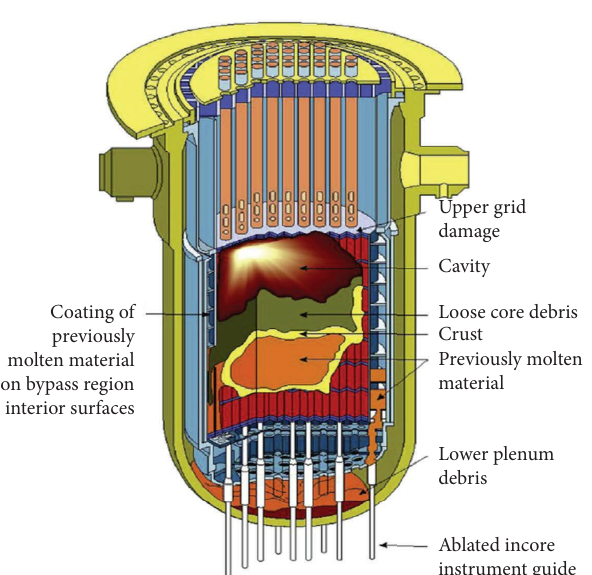
Figure 2: End state of TMI-2 severe